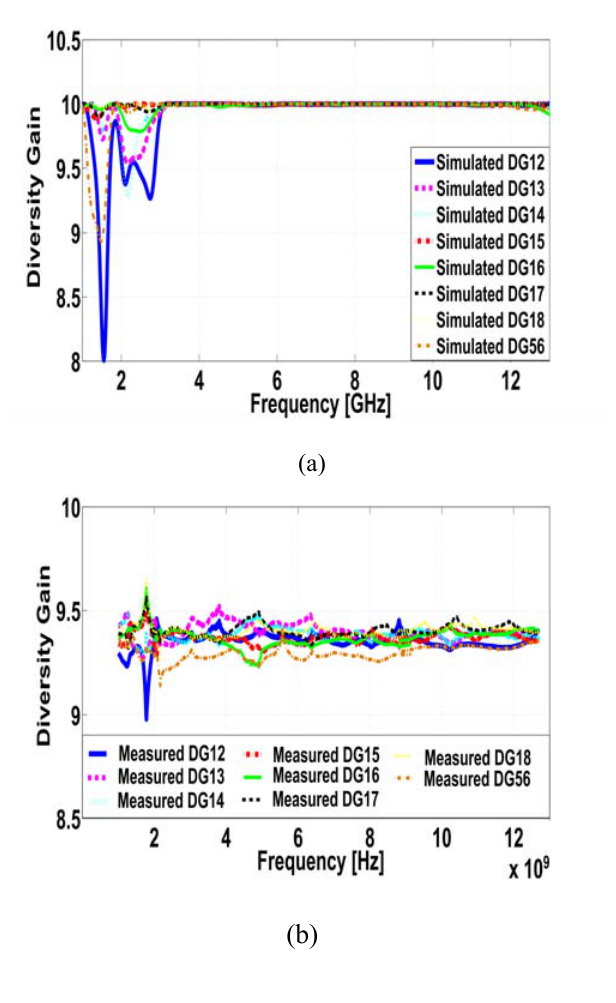
FIGURE. 13 Simulated and measured diversity gain comparison, (a) simulated DG, (b) measured DG